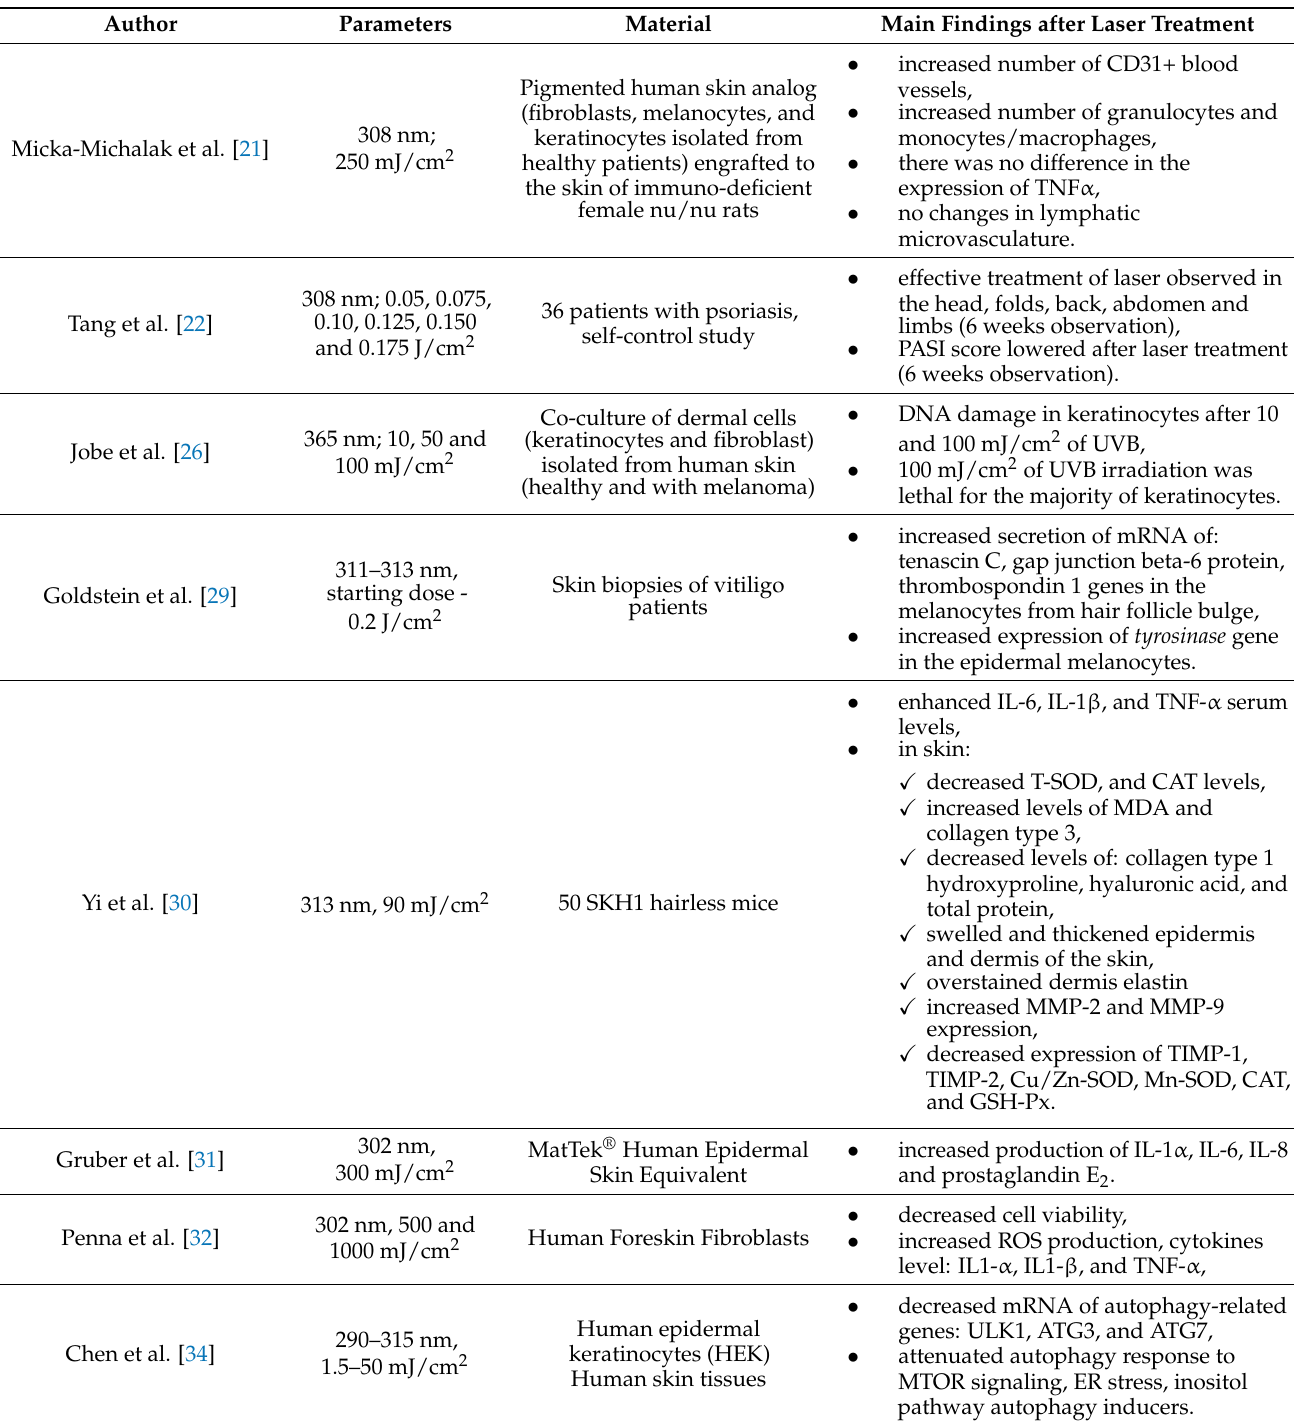
Table 1. UV light (10–400 nm) effect on skin